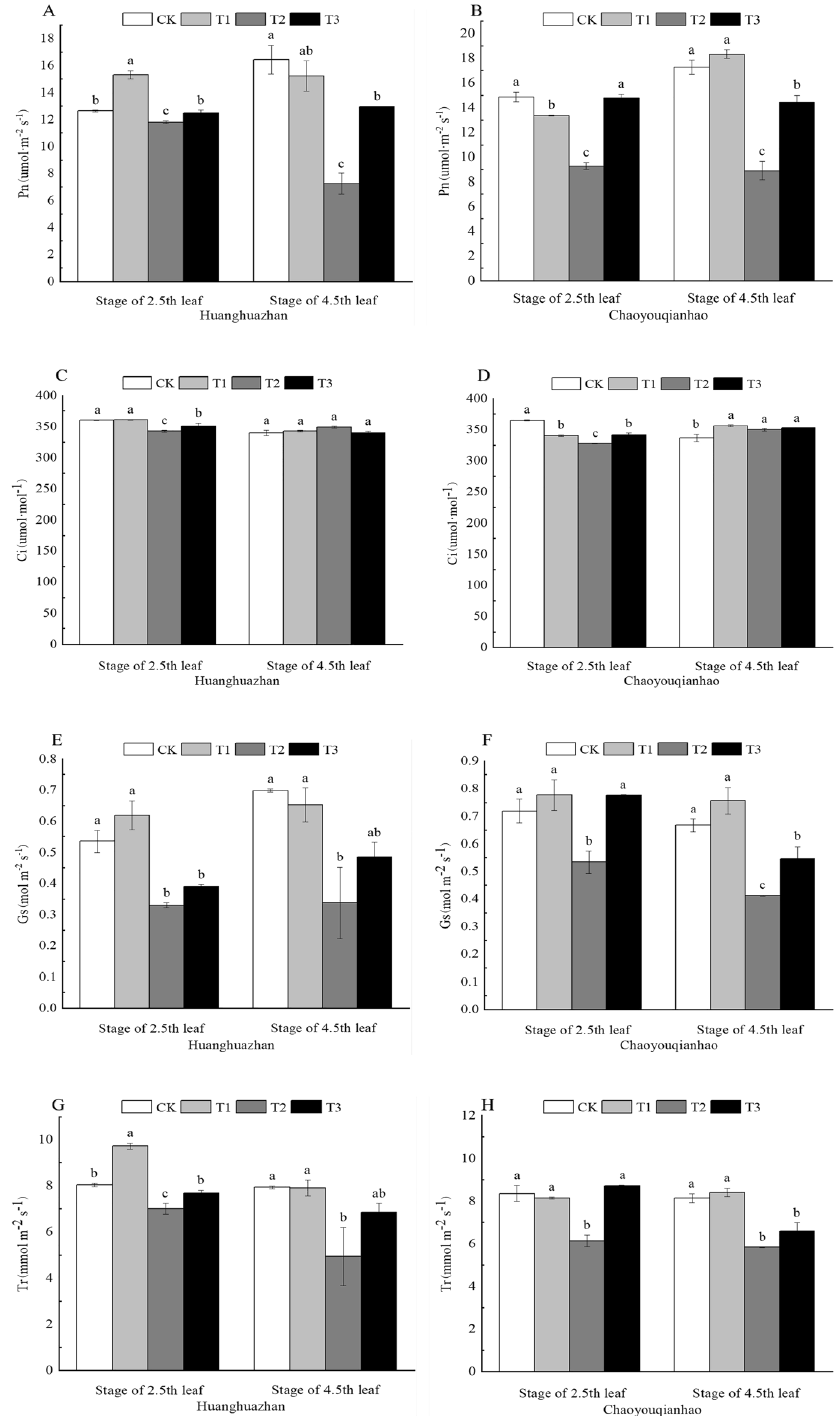
Figure 3. Effect of soaking with BR on gas exchange parameters of rice seedlings under salt stress. Different lowercase letters indicate significant differences at the P < 0.05 level. CK: soaking with distilled water + watering 0 g L −1 NaCl. T1: soaking with BR + watering 0 g L −1 NaCl. T2: soaking with distilled water + watering 3 g L −1 NaCl. T3: soaking with BR + watering 3 g L −1